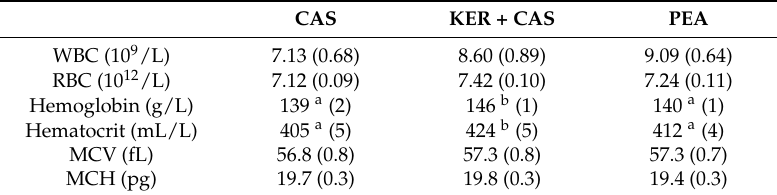
Table 4. Hematological parameters 1 of blood from rats after 4 weeks of being fed on test diets containing 18% w/w protein sourced from casein (CAS), 50:50 w/w keratin and casein (KER + CAS), or yellow pea flour (PEA) 2 .